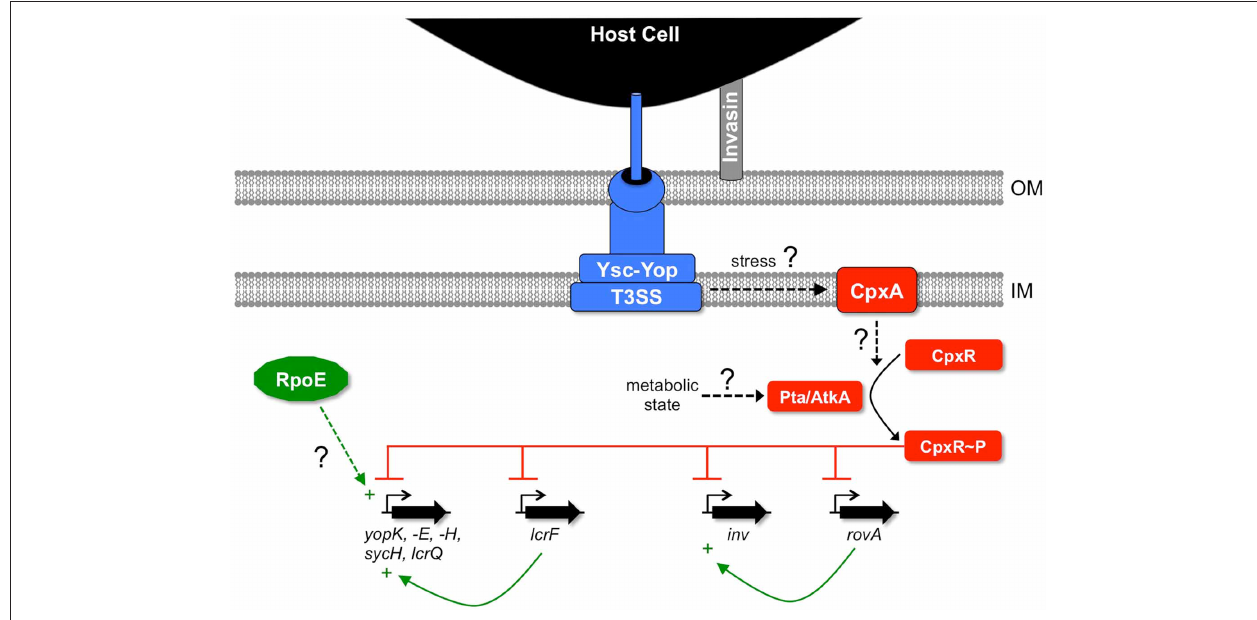
FIGURE 2 | Links between ESRs and regulation of the Ysc-Yop T3SS in Y. pseudotuberculosis . CpxR ∼ P down-regulates genes encoding components of the Ysc-Yop system by binding directly to their promoters. It also inhibits expression of the gene encoding the master positive regulator of the ysc-yop genes, lcrF , by the same mechanism. CpxR ∼ P also represses expression of the genes encoding invasin ( inv ) and its positive regulator RovA. This further inhibits the function of the Ysc-Yop system by compromising the attachment to host cells that is required for efficient Yop